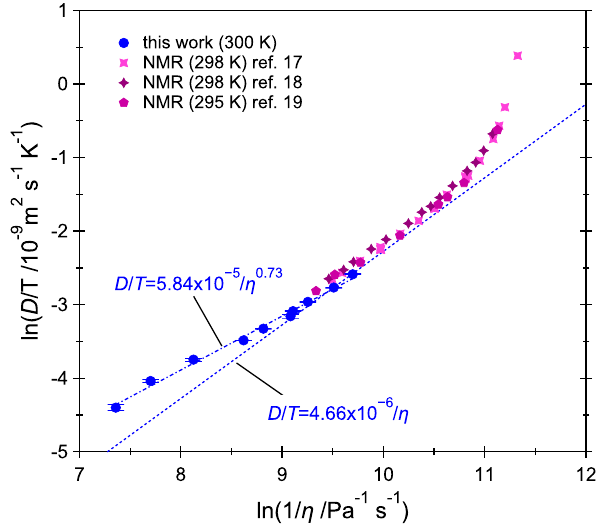
Fig. 5 Test of the Stokes – Einstein – Sutherland and fractional Stokes – Einstein – Sutherland relations. ln( D / T ) as a function of ln(1/ η ), with self-diffusion coef fi cient values from this work and from refs. 17 – 19 and viscosity values from refs. 22,50 . Error bars correspond to one standard deviation. The best fi t to our data using a fractional Stokes – Einstein – Sutherland relation ( D / T = K / η ξ ) is shown as dash-dotted line and the values of K and ξ are indicated. The Stokes – Einstein – Sutherland relation (dashed line) predicts D / T = K / η